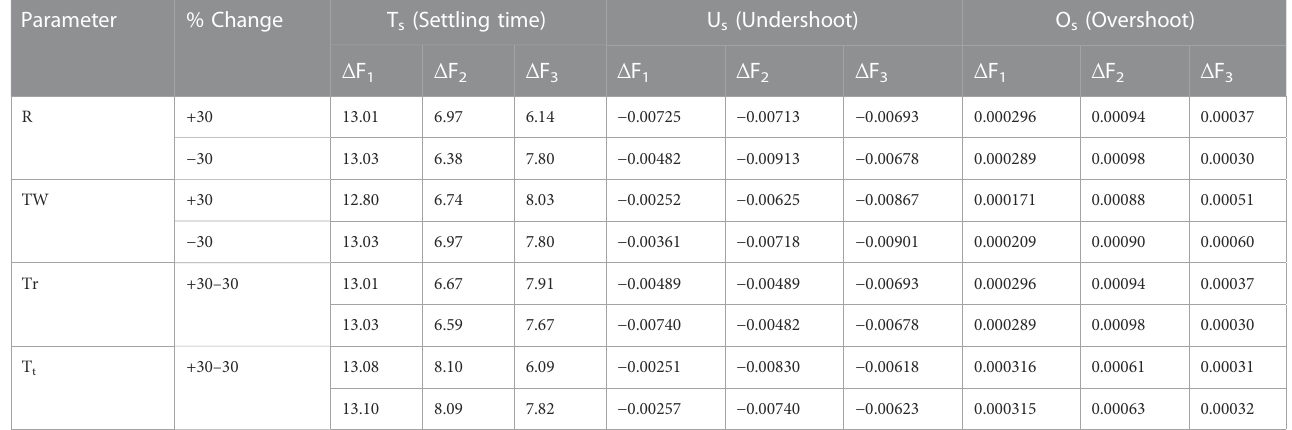
TABLE 5 Sensitivity analysis for proposed FOA based MRPID controller.